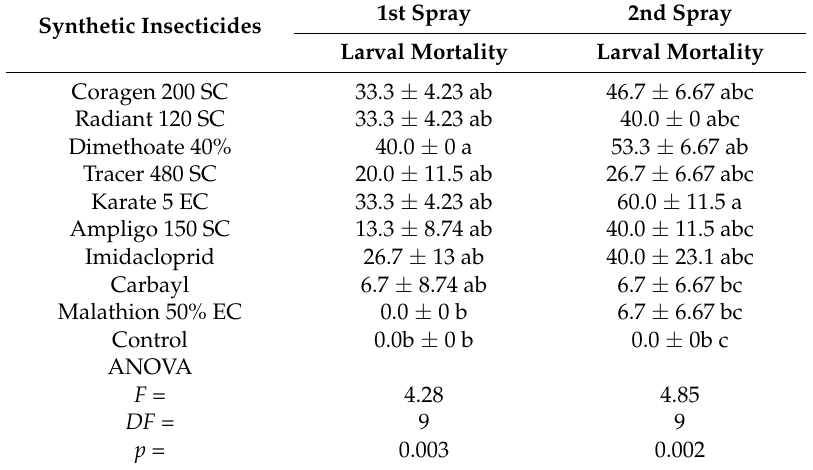
Table 4. Mean percentage ( ± SEM) FAW larval mortality at two different spray times in the